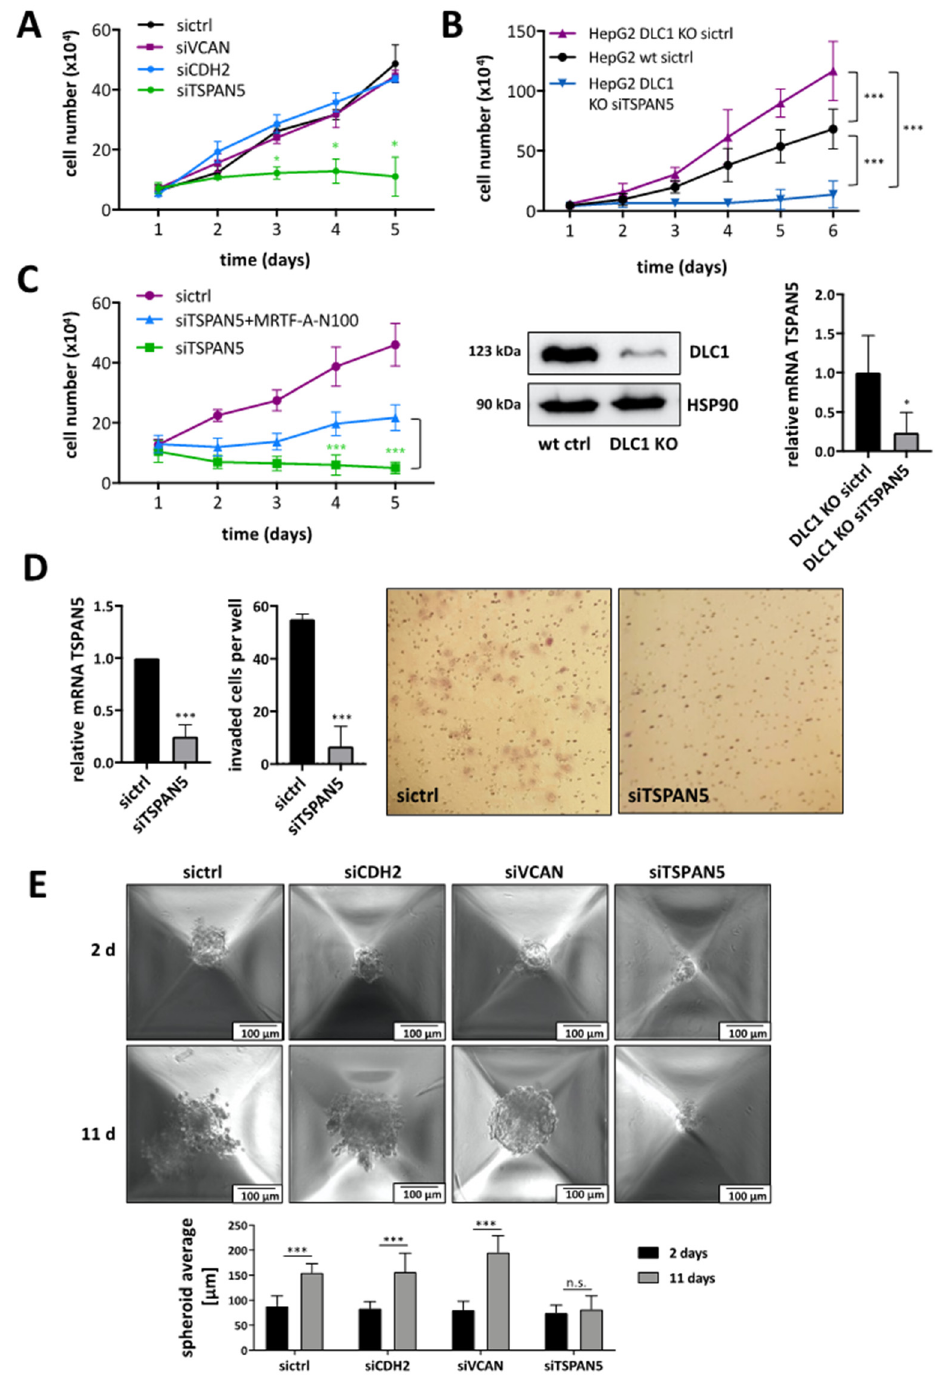
Figure 3. Requirement of TSPAN5 for HCC proliferation, migration, invasion and spheroid formation. ( A ) HuH7 cells transiently transfected with negative control (sictrl) and TSPAN5, CDH2 or VCAN siRNA (siTSPAN5, siCDH2 and siVCAN) were counted daily for 5 days. Values are means ± SD ( n = 3); *, p < 0.05. ( B ) HepG2 DLC1 wt (HepG2 wt) cells transiently transfected with negative control (sictrl) as well as HepG2 DLC1 KO cells transiently transfected with negative control (sictrl) and TSPAN5 siRNA (siTSPAN5) were counted daily for 5 days. Values are means ± SD ( n = 3); *** p < 0.001. Lysates of HepG2 DLC1 wt (wt ctrl) and HepG2 DLC1 KO (DLC1 KO) cells were immunoblotted with anti-DLC1 and anti-HSP90 antibodies to demonstrate the DLC1 KO. Representative blots of three independent experiments are shown. TSPAN5 knockdown efficiency was determined by qRT-PCR with gene-specific TSPAN5 and 18S rRNA primers. Values are means ±